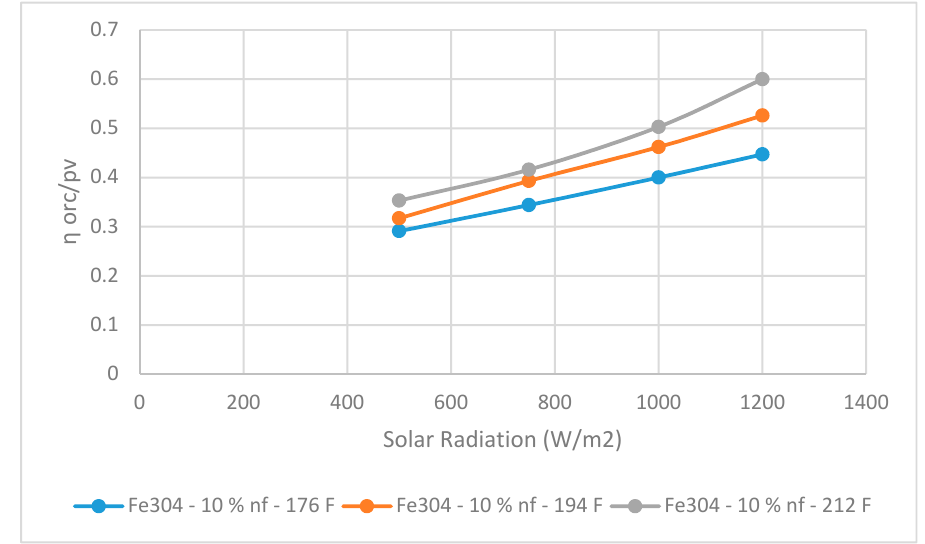
Figure 7. Hybrid system efficiency for Nanofluid SiO 2 at different temperatures and 10% volumetric concentration.